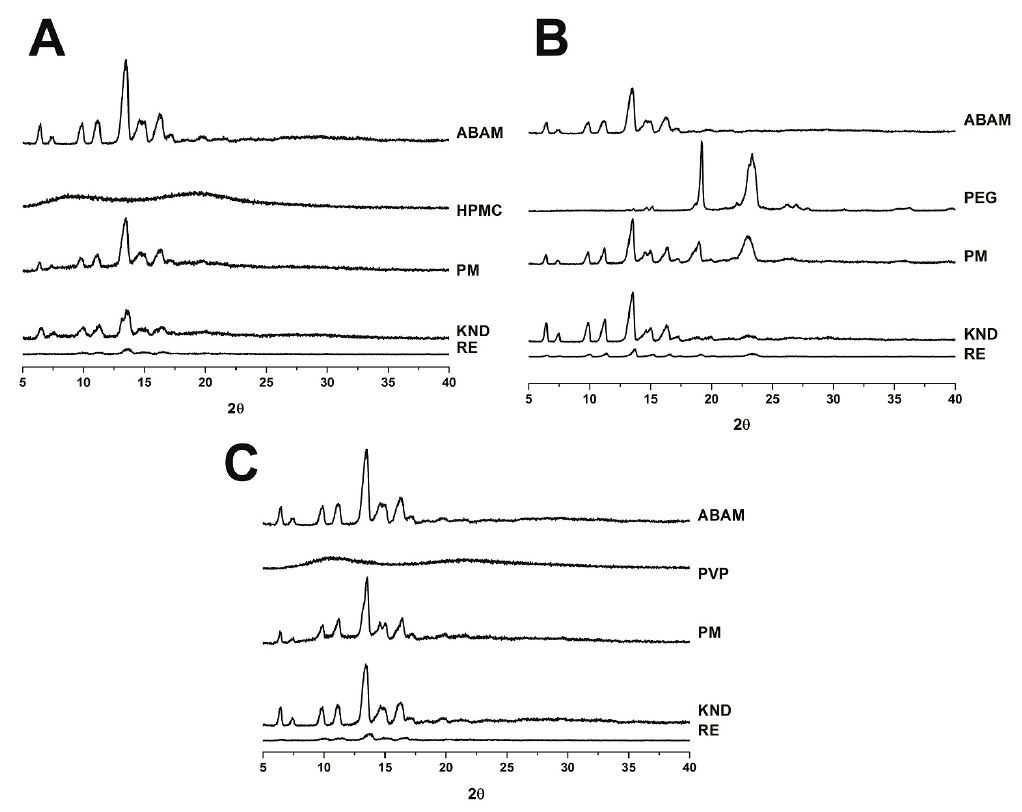
Figure 3. X-ray diffractograms of solid dispersions of ABAM with HPMC ( A ) PEG 6000 ( B ) and PVP K-30 ( C ).